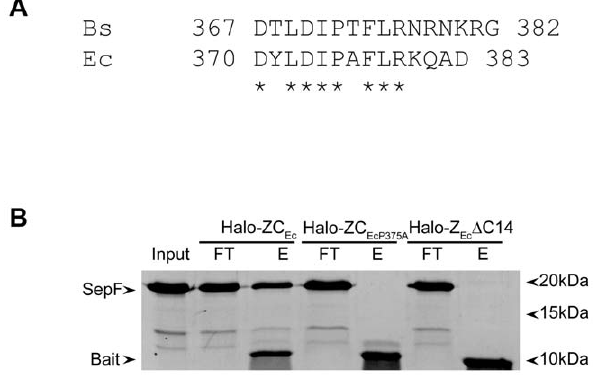
Figure 5. SepF binds to the C-terminus of E. coli FtsZ. (A) Alignment of the C-termini of B. subtilis (Bs) and E. coli (Ec) FtsZ. Identical residues are marked with an asterisk. (B) Pull down experiments using Halo-ZCEc, Halo-ZC EcP372A or Halo-Z Ec D C14 bound to resin, with wild type SepF as prey protein. The input material (Input), flow-through (FT) and eluate (E) fractions of the experiment are shown and relevant proteins are indicated on the left.